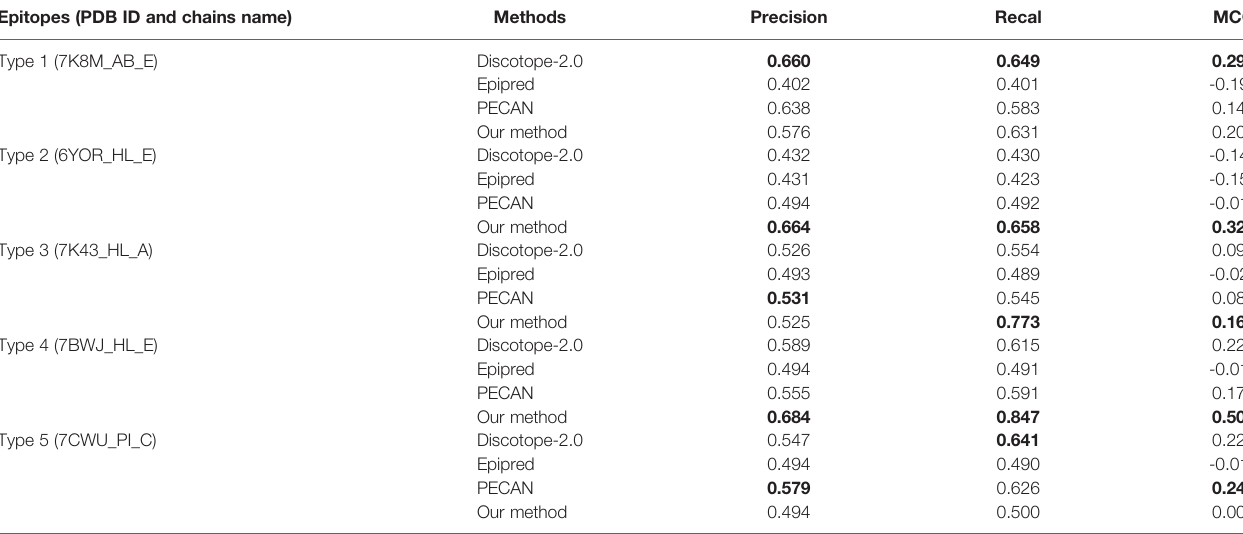
TABLE 4 | Prediction performances on fi ve types of SARS-Cov-2 BCEs and best values are in bold. Epitopes (PDB ID and chains